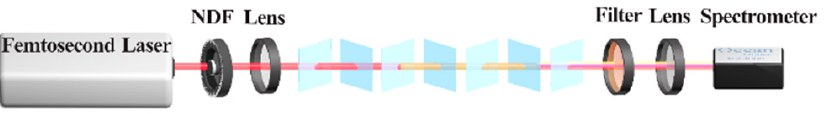
Figure 1. Schematic of the experimental setup (NDF: neutral density filter).